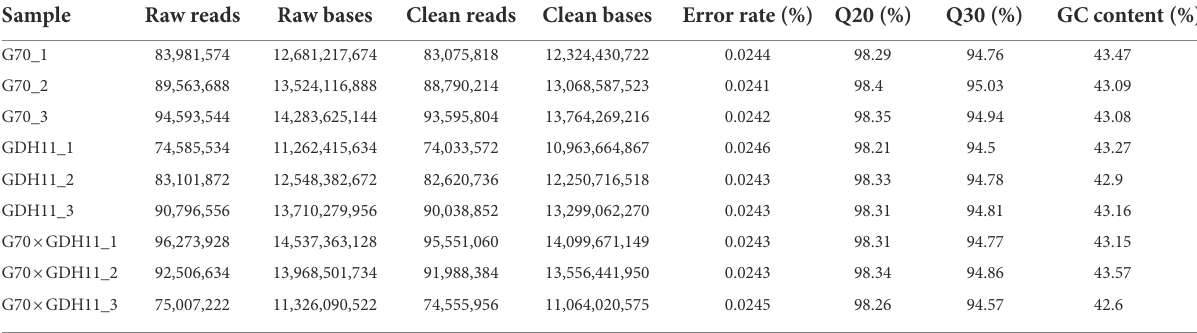
TABLE 1 Statistical table of sequencing data of three materials. Sample